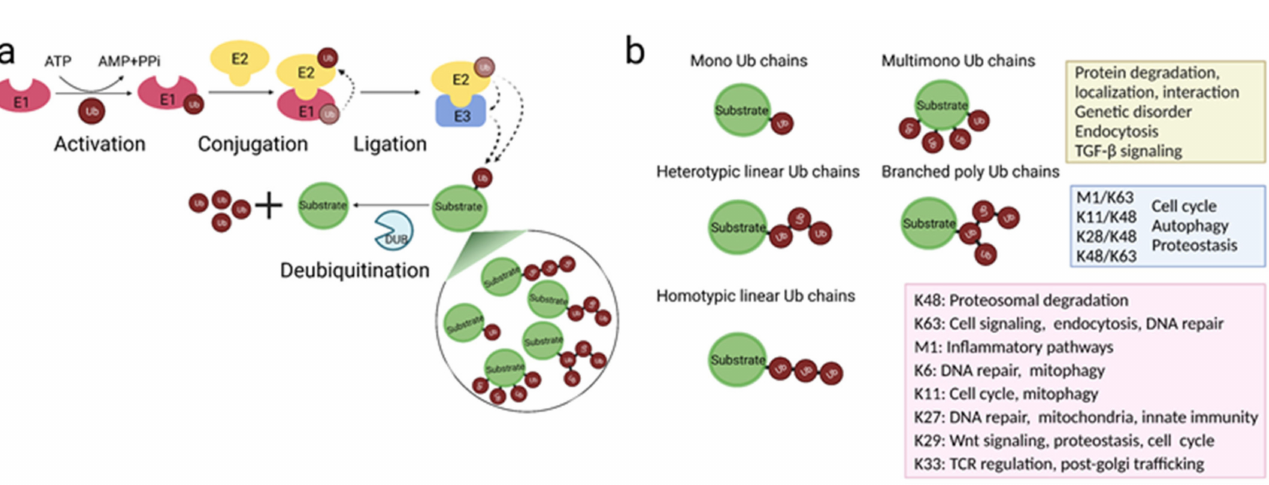
Figure 1. Mechanisms and functions of the ubiquitin system. ( a ) Enzymatic steps and enzymes involved in protein ubiquitination, a reversible and versatile post-translational modification. ( b ) Types of ubiquitin chains and their, thus far, identified cellular functions. Each ubiquitin chain has a different topology and is presumed to have distinct functions. The lysine 48 (K48)- and lysine 63 (K63)-linked polyubiquitin chains are abundant and well-studied; for the other types of chains, many known as atypical chains, cellular functions are starting to be revealed. Ub: ubiquitin; E1: ubiquitin-activating enzyme; E2: ubiquitin-conjugating enzyme; E3: ubiquitin ligase; DUB: deubiquitinase; AMP: adenosine monophosphate; ATP: adenosine triphosphate; PPi: inorganic pyrophosphate; K: Lysine; M: methionine; TGF- β : transforming growth factor- β . Illustration created using BioRender